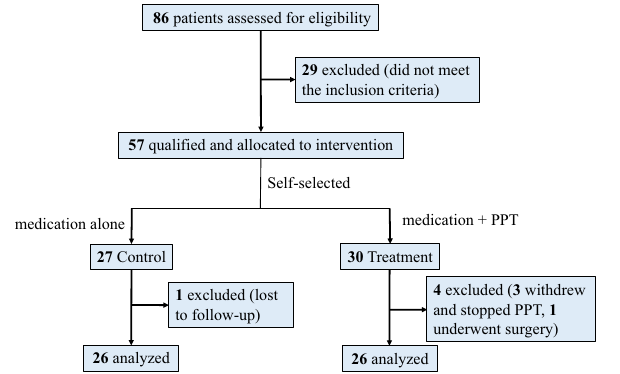
Figure 1. Participant flow diagram.